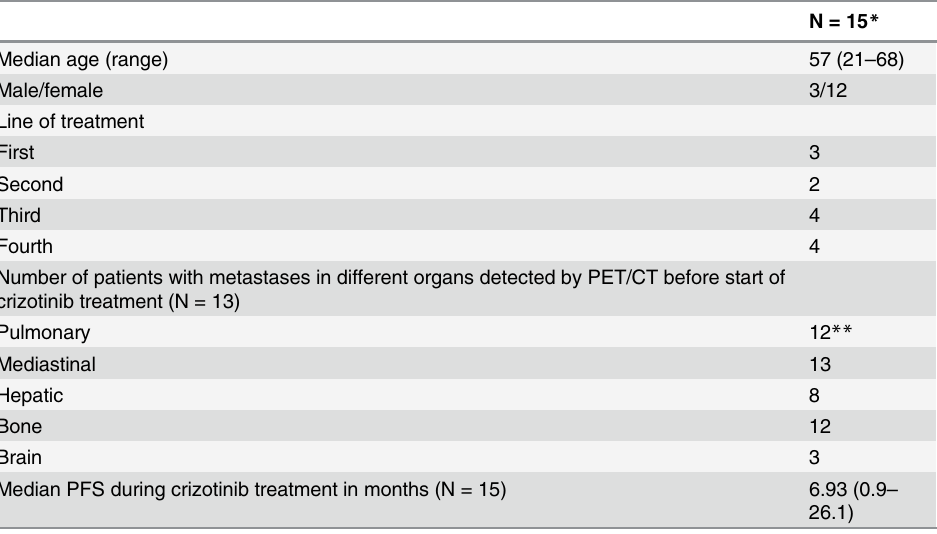
Table 1. Baseline patient